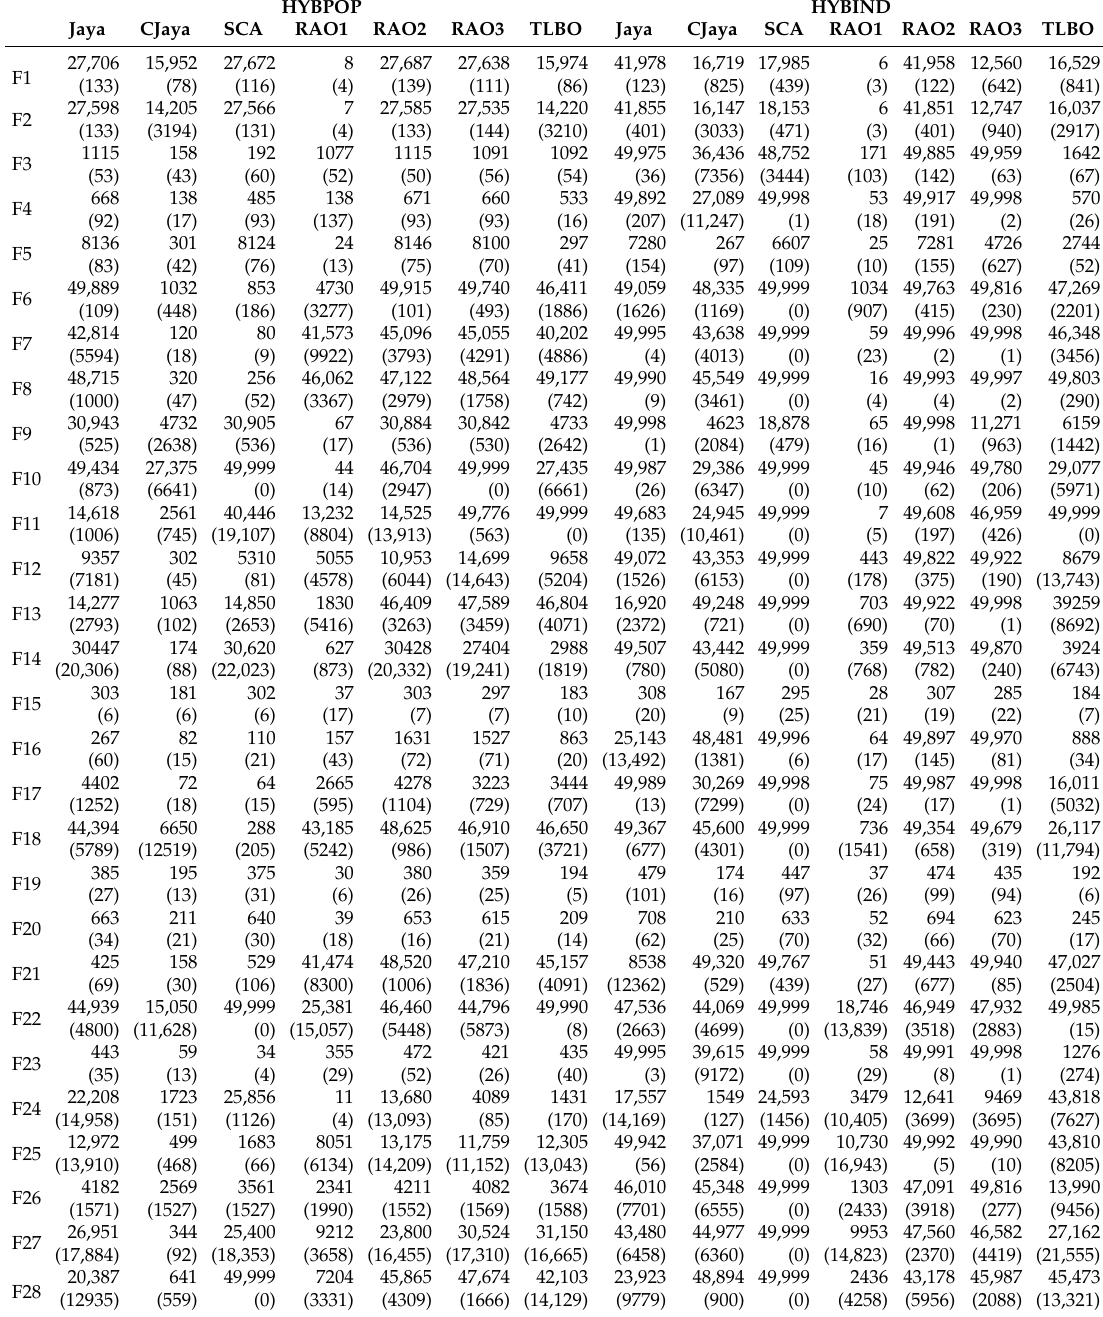
Table 9. Last iteration in which a replacement of any individual occurs (LtI-AI). The population size is set as